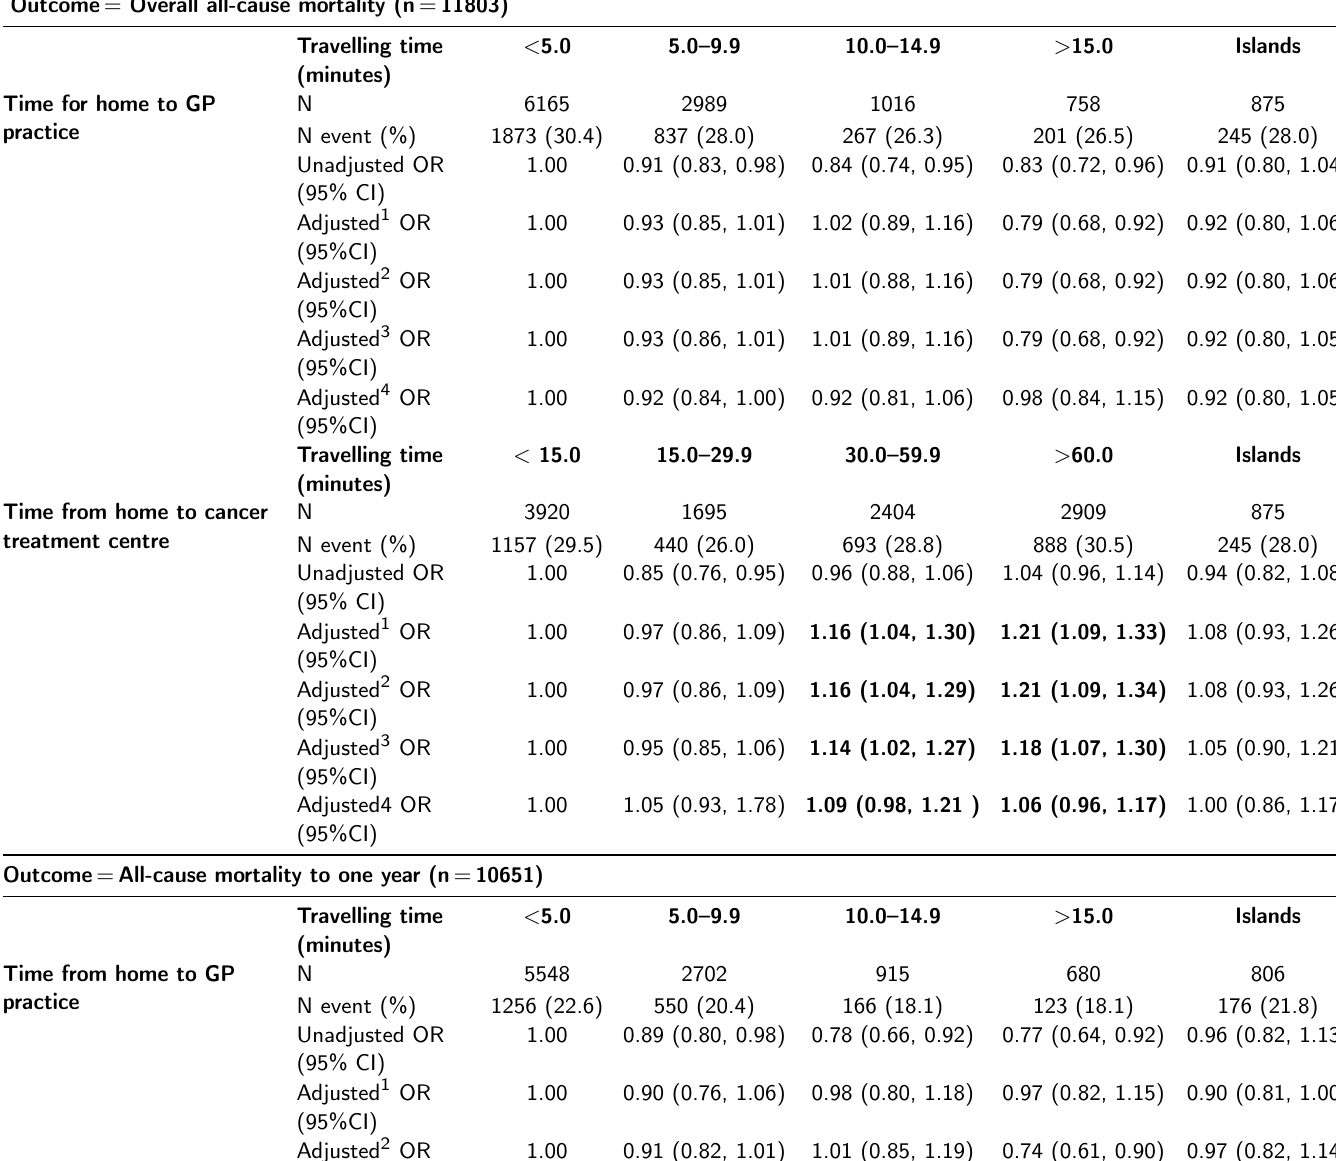
Table 7: Patient mortality outcomes with travelling time from home to GP and cancer treatment centre Outcome = Overall all-cause mortality (n =